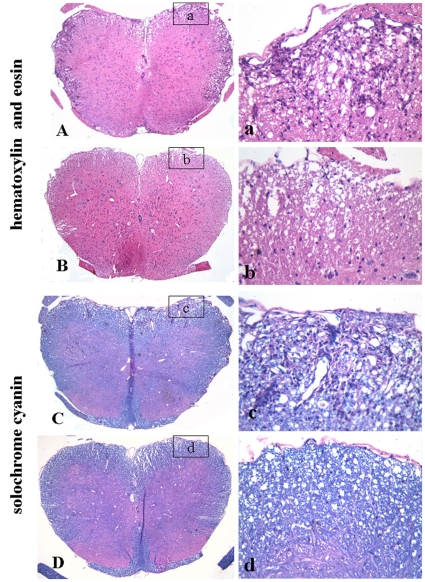
The representative sections depicting the inflammation and demyelination in the lumbar spinal cord of EAE mice by PBS and berberine treatment.Inflammatory infiltration was widespread in the PBS-treated EAE mice (A), but which was attenuated by berberine treatment (B). A large plaque of demyelination was seen in the PBS-treated EAE mice (C), and demyelination was attenuated in berberine-treated EAE mice (D). a-d were higher magnification views of the boxed areas in A, B, C and D, respectively. A-D: ×40; a-d: ×400.